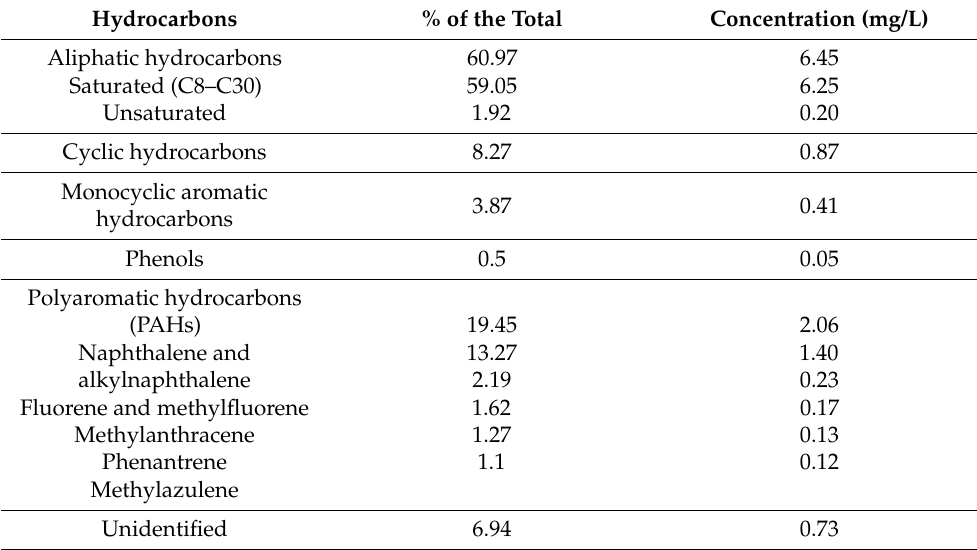
Table 1. Qualitative and quantitative composition of hydrocarbons